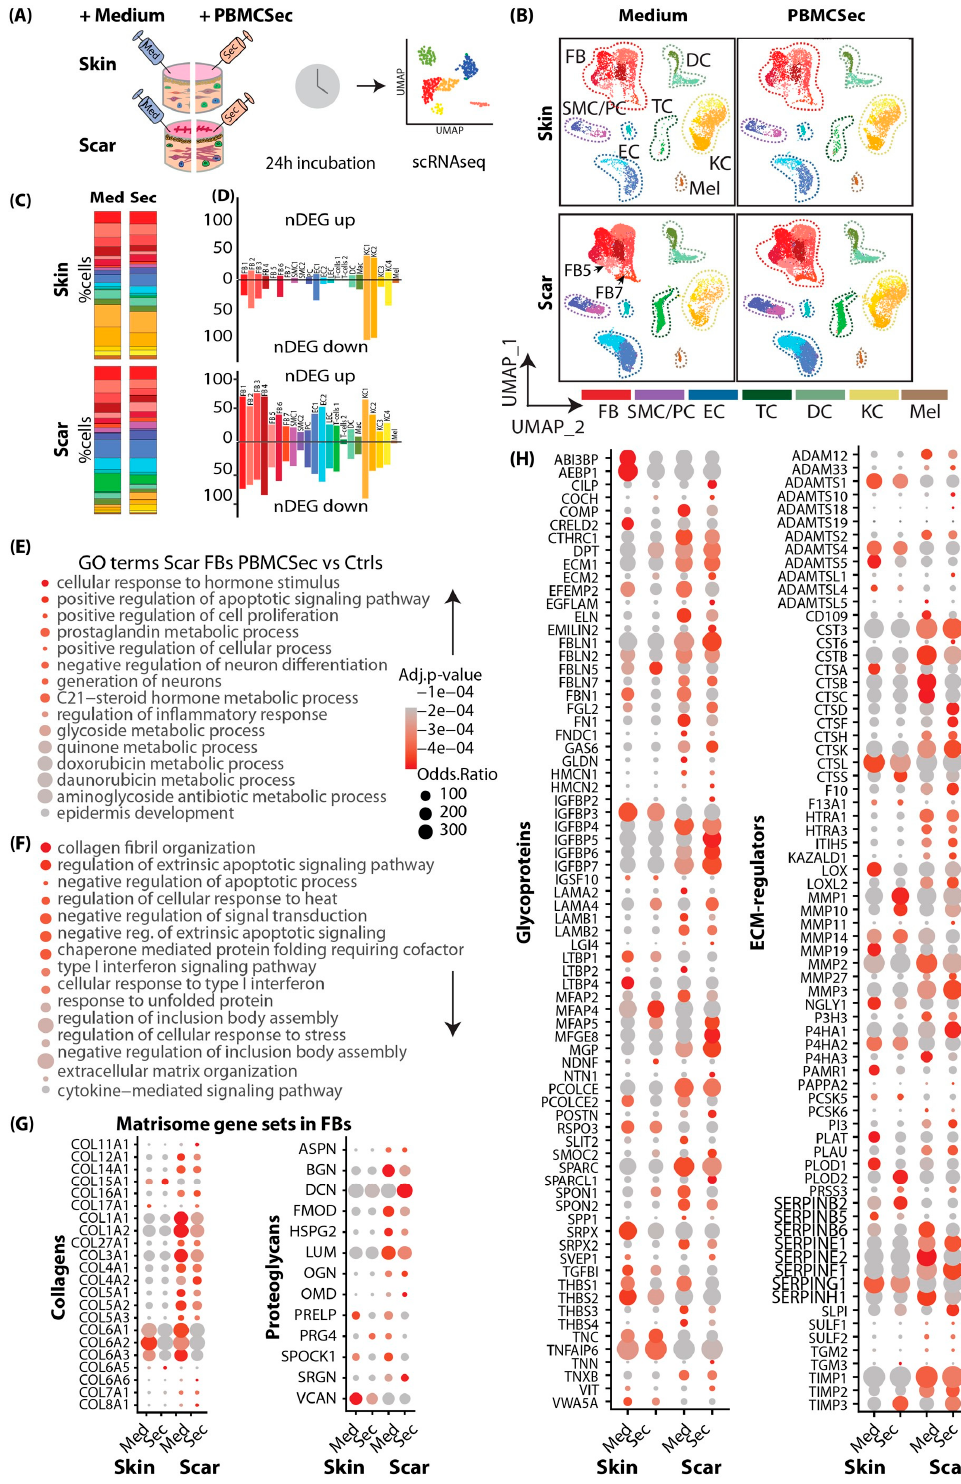
Figure 4. scRNAseq analysis of human skin and scars treated with PBMCsec ex vivo shows strong similarities to mouse models. ( A ) Illustration of scRNAseq workflow in human skin and scar samples. Skin and scar biopsies were incubated overnight in medium or PBMCsec and subjected to scRNAseq. ( B ) UMAP clustering of human skin and scar, split by condition. Seven fibroblast clusters (FB 1–7; red), smooth muscle cells (SMCs) and pericytes (PCs; purple), endothelial cells (ECs; blue),